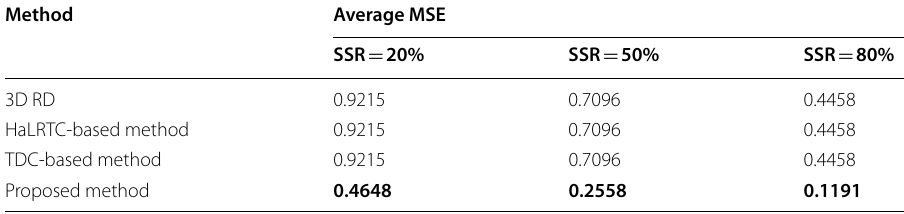
The optimal values are shown in bold